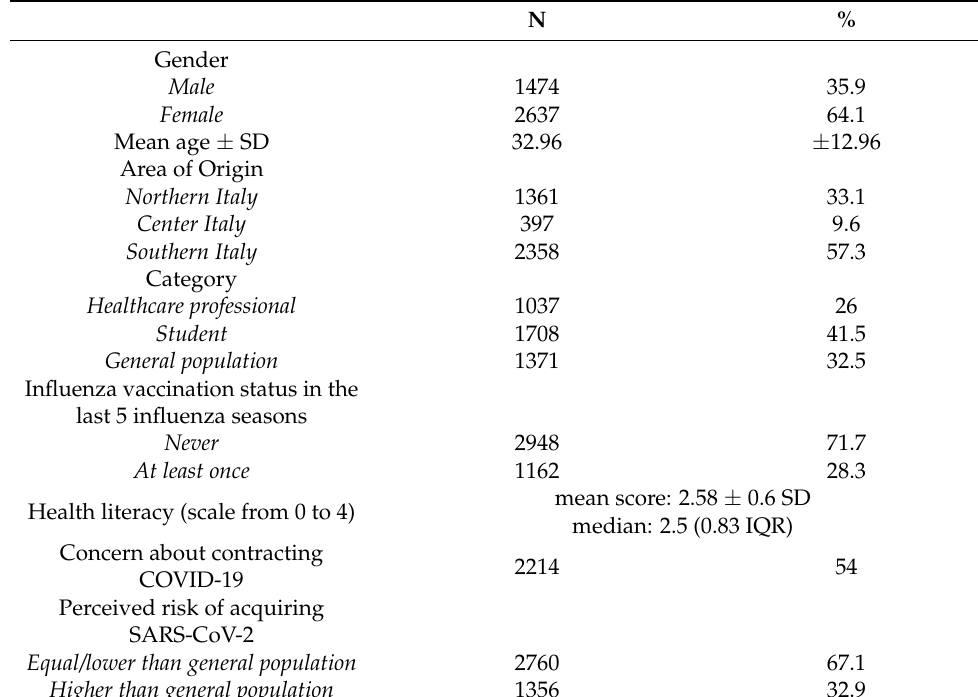
Table 1. Sociodemographic and working characteristics of the study sample ( n = 4116).